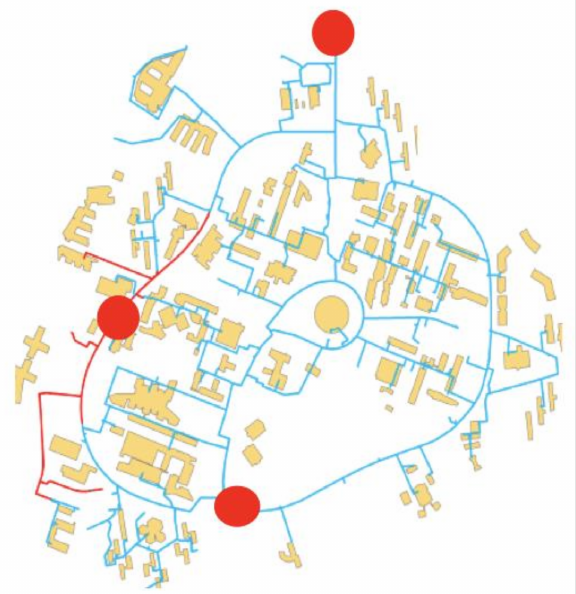
Figure 1. The water distribution system of the scientific campus [25] (the red circles indicate the water supply of the